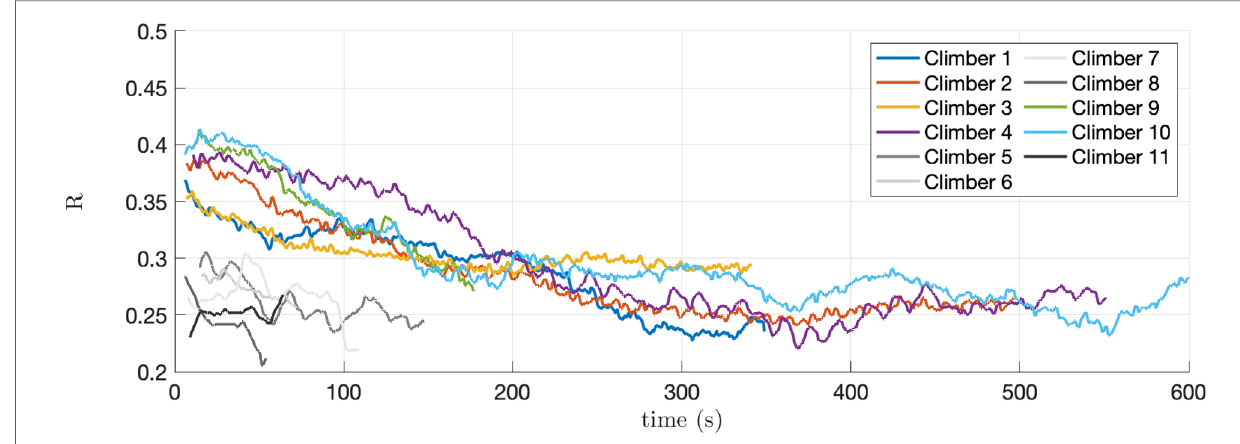
FIGURE 10 Hands to total force ratio R ( t ), de fi ned in Eq. (1), for the 11 test